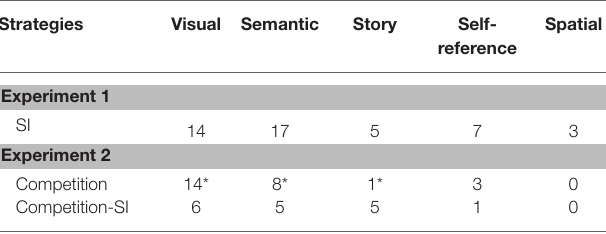
TABLE 1 | The number of participants who selected the different encoding strategies in Experiments 1 and 2.